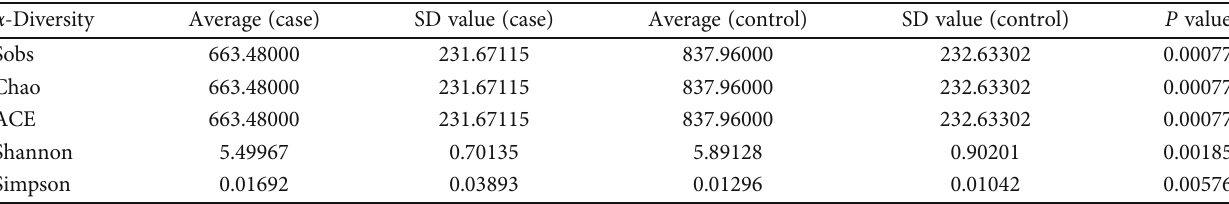
Figure 5: The α -diversity box plots of the 2 groups: (a) the Sobs; (b) Chao; (c) ACE; (d) Shannon; (e) Simpson is a type of α -diversity index. Each dot represented one sample by pink (case group) or blue (control group) in the map. Sobs: number of observed species; ACE: abundance-based coverage estimator. Table 2: The statistics of the α -diversity